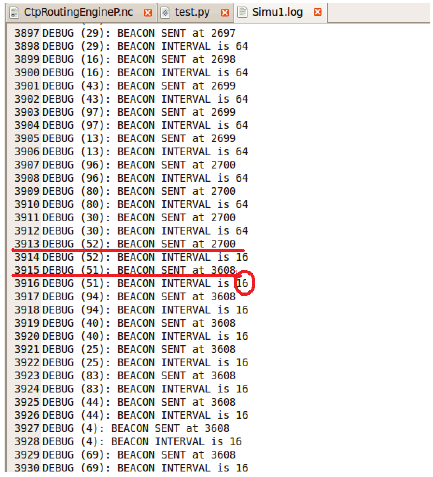
Figure 8: Simulation result of dynamic routing mechanism